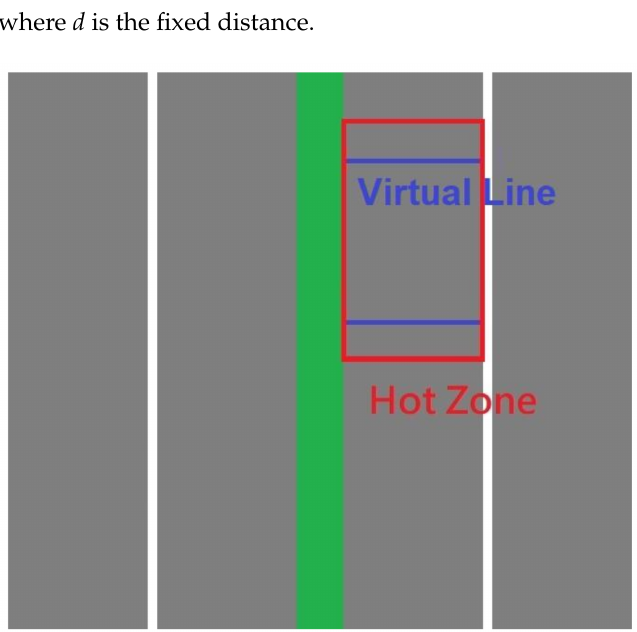
Figure 6. Two virtual lines and hot zone for the velocity calculation (conceptualization).